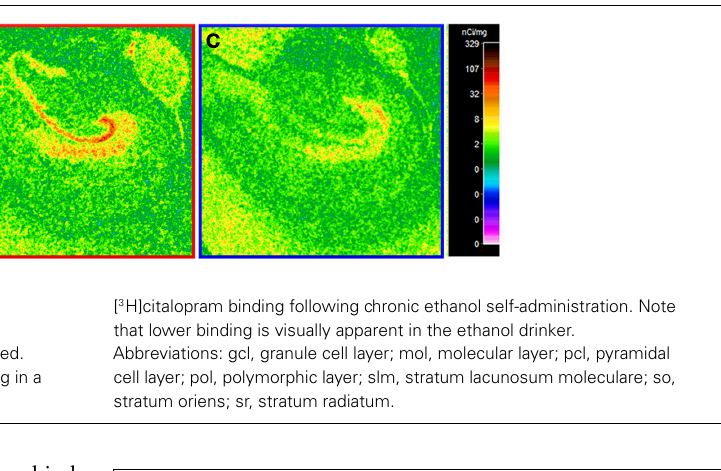
FIGURE 1 | Representative [ 3 H]citalopram binding in ethanol drinkers and controls. (A) A nissl stain of the non-human primate hippocampus in coronal view with relevant regions and layers labeled. (B) A representative example of hippocampal [ 3 H]citalopram binding in a healthy control. (C) A representative example of hippocampal